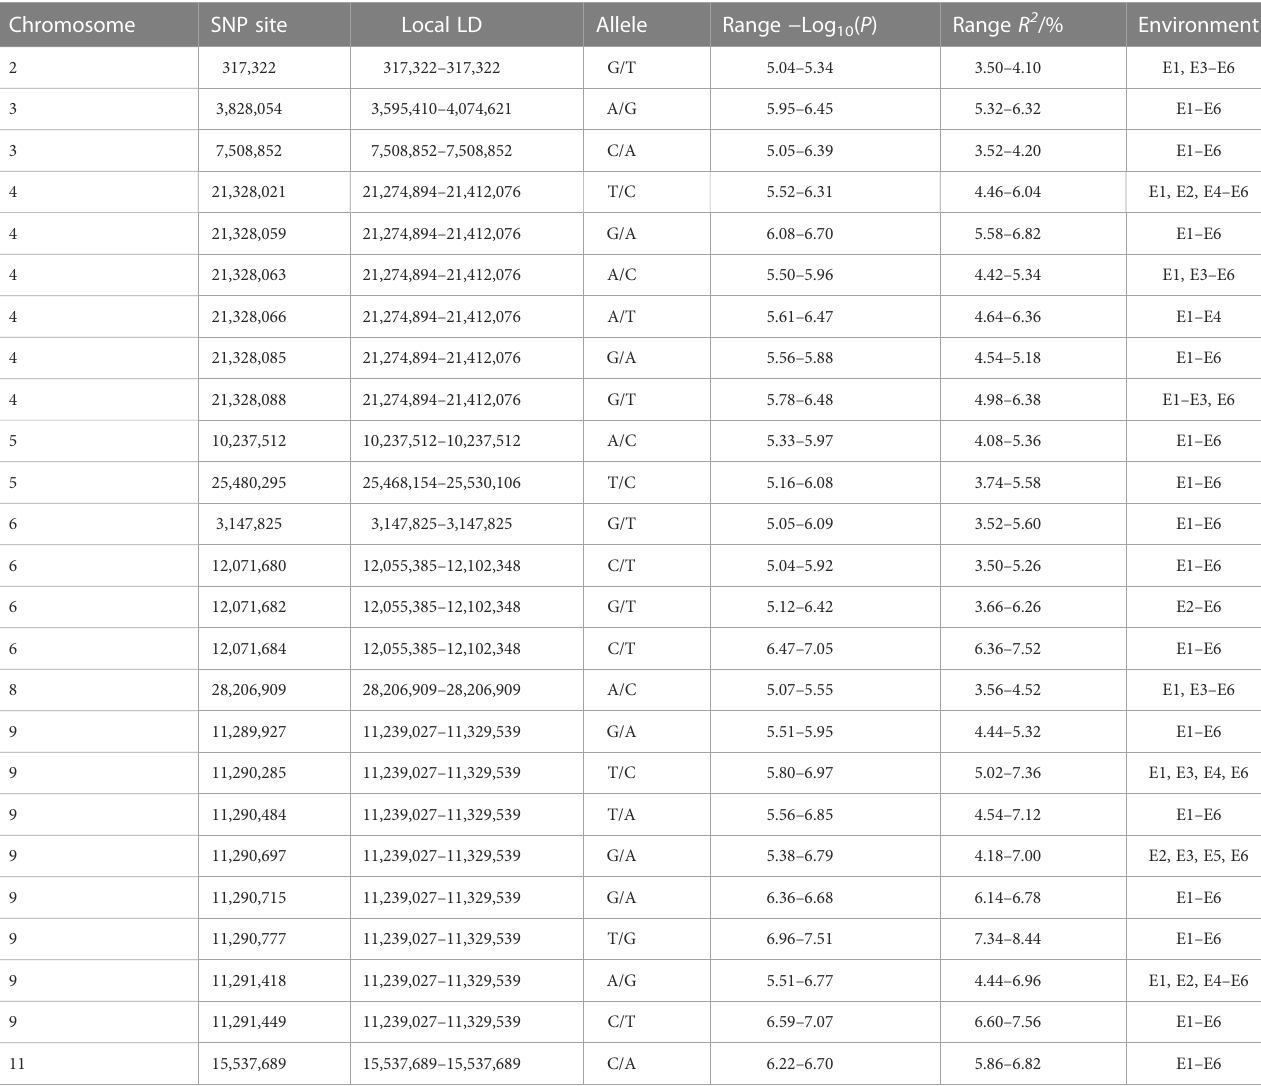
TABLE 1 The summary of SNPs signi fi cantly associated with PEL.